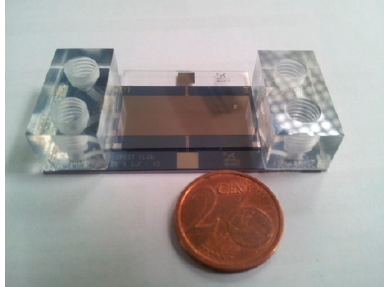
Figure 3. The device equipped with the two acrylic